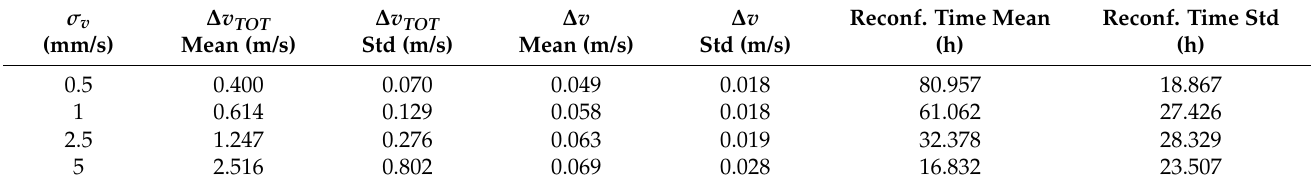
Table 4. Statistics related to the sensitivity analyses for maintenance of low-inclined formations in the presence navigation errors ( σ p = 1 cm).